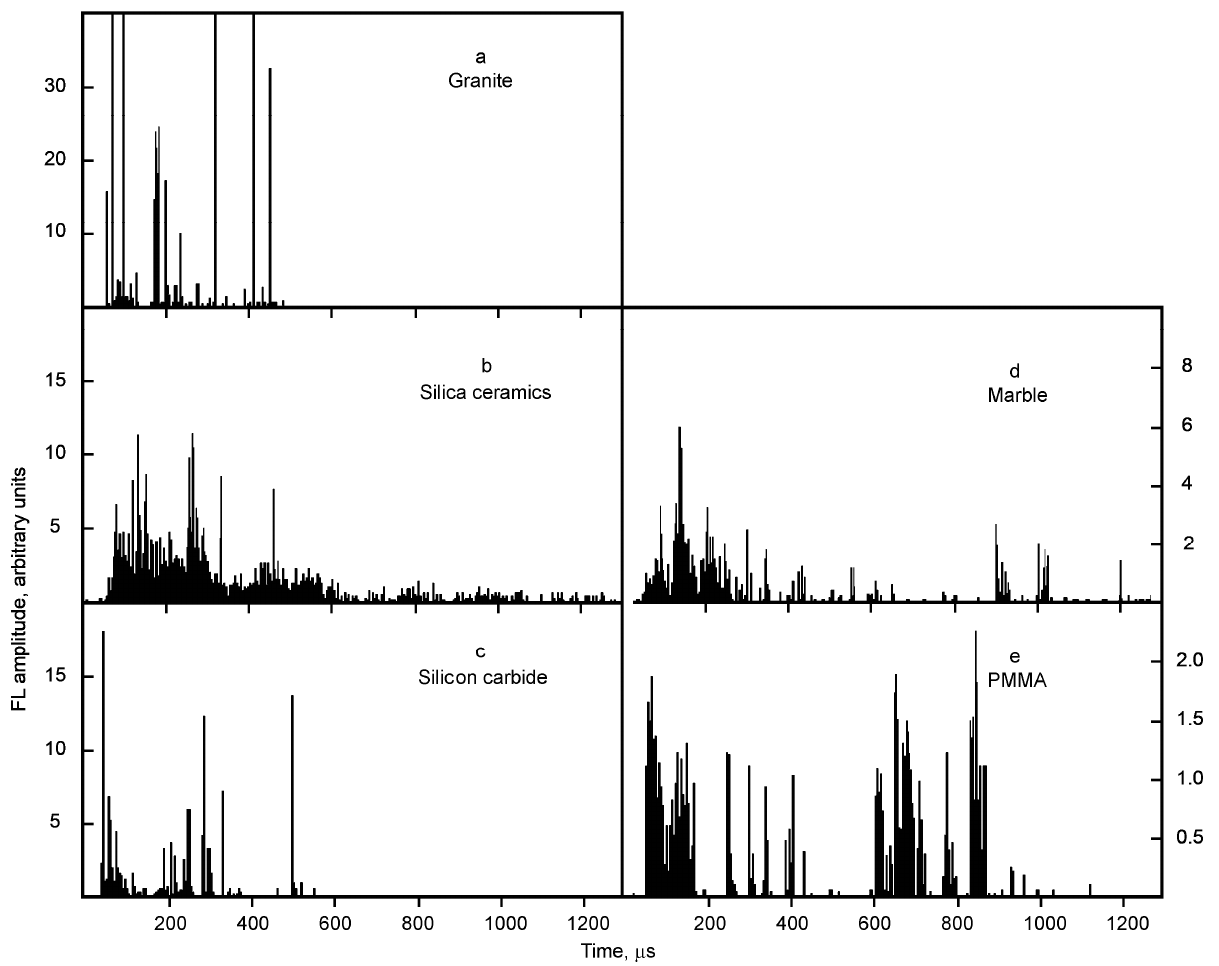
Figure 2: Time series of FL signals from fracturing